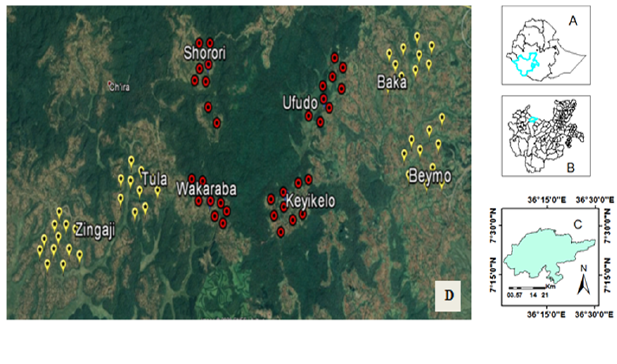
Fig. 1. Study area map produced from Landsat images taken in 2018 and 2019. (A) map of Ethiopia; (B) map of Ethiopian Southern Nations, Nationalities, and Peoples' Region; (C) map of Gimbo district; (D) study sites; red markers denote residences near to forest and yellow markers denote residences far away from the